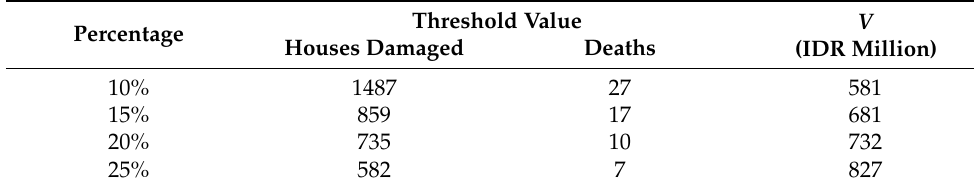
Table 7. Different percentages of threshold